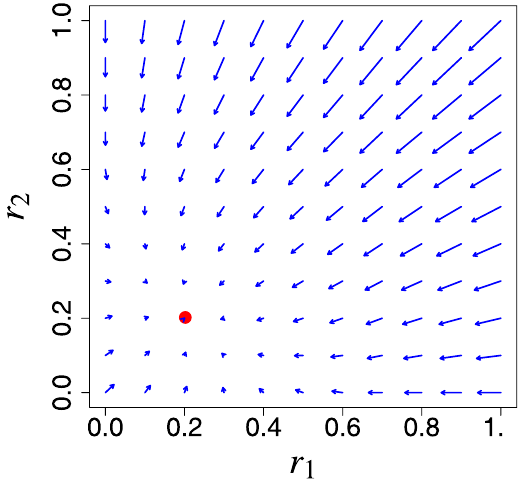
Figure 4. Plot of the vector field ( f ( r 1 ) − r 1 , f ( r 2 ) − r 2 ). The red spot is the Nash equilibrium point. Parameters: q C = 0.1, q I = 0.1, q O = 0.8, and N = 2.